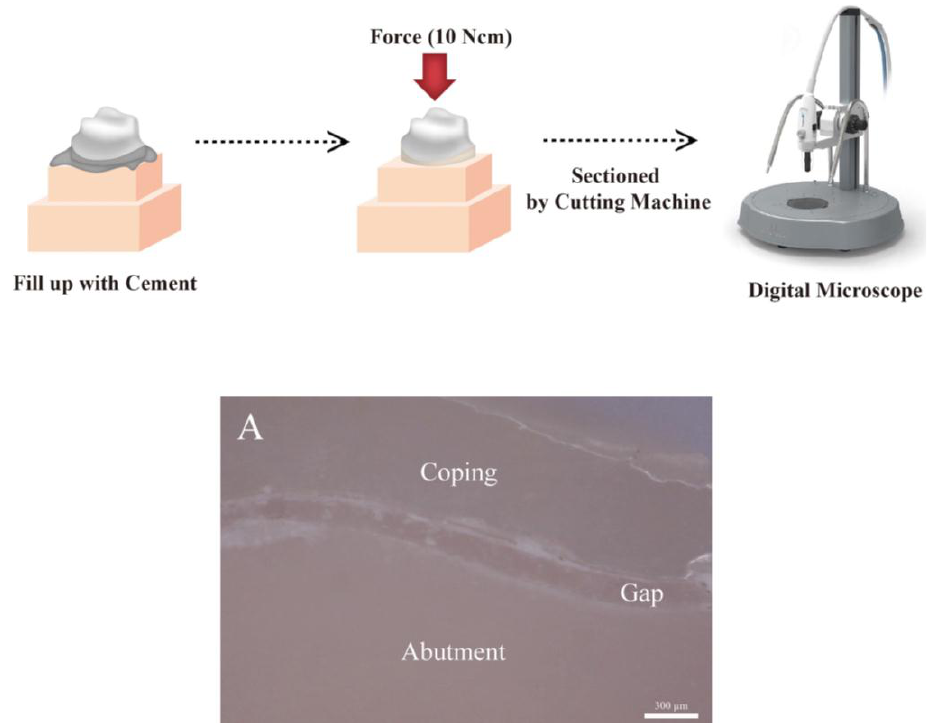
Figure 4. Schematic of the cross-sectional method (CSM). ( A ) Cross-sectional image of CSM for the occlusal gap.